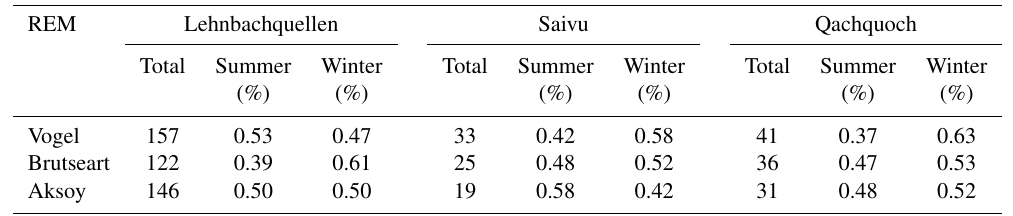
Table 4. Recession event period extracted by the REMs for the three spring discharge hydrographs.